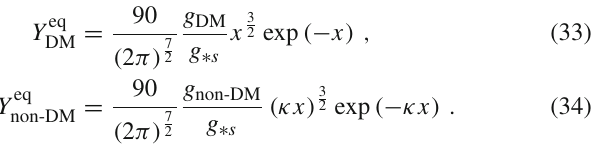
Fig. 1 Examples of dark sector annihilations via Yukawa couplings (upper row), Higgs portal couplings and gauge couplings in leptophilic DM